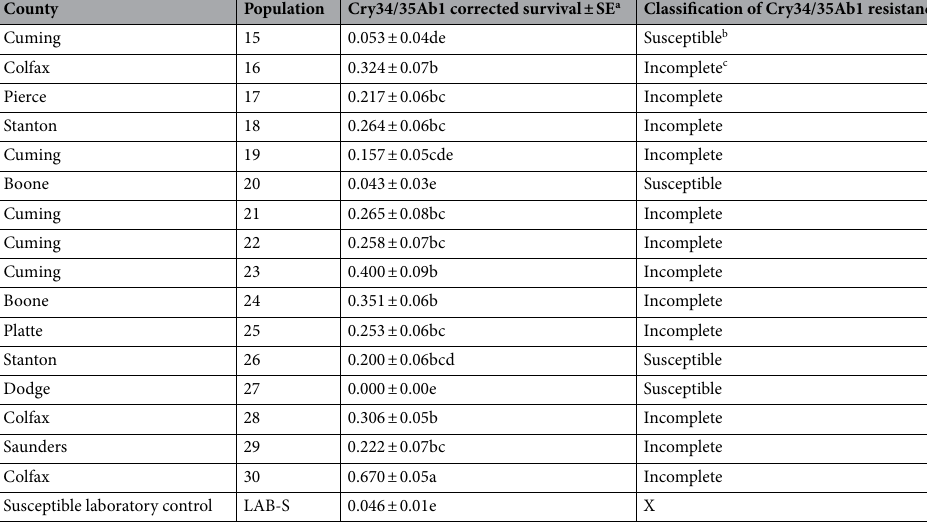
Table 2. Corrected survival (± SE) of western corn rootworm populations assayed on Cry34/35Ab1 maize during 2020. a Corrected survival values followed by the same lowercase are not significantly different ( p > 0.05); b susceptible criteria: no difference in survival on Cry34/35Ab1 maize compared to the LAB-S control; c incomplete resistance criteria: (1) significantly greater survival on Cry34/35Ab1 maize compared to the LAB-S control, and (2) within a population, proportional survival and/or larval development was significantly lower on Cry34/35Ab1 maize relative to non-RW Bt